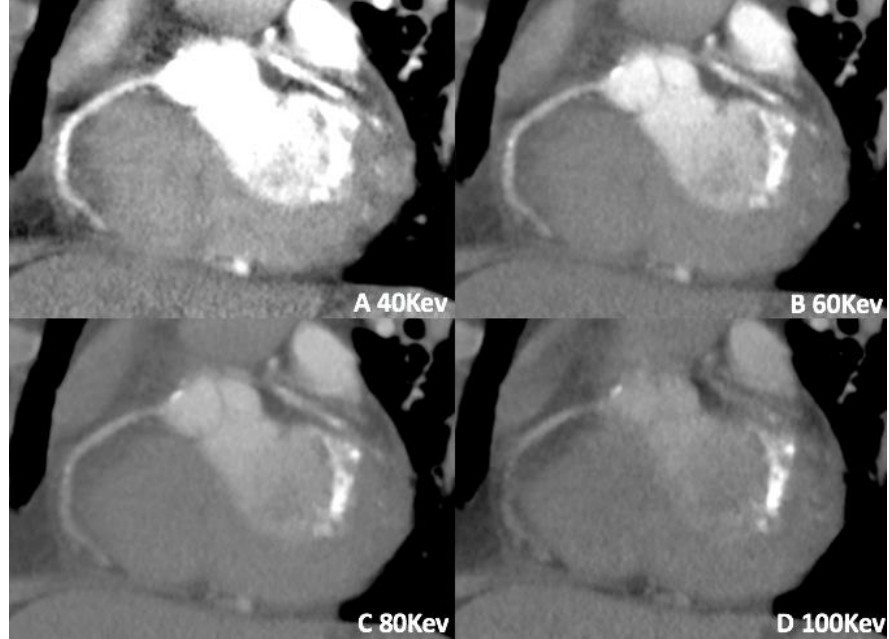
Figure 3. Retrospective application of VMI ( A – D ) by dual-source DECT in a patient where the contrast bolus was mistimed in amount; low keV reconstruction increases the attenuation of iodinated contrast material, allowing for greater contrast-to-noise